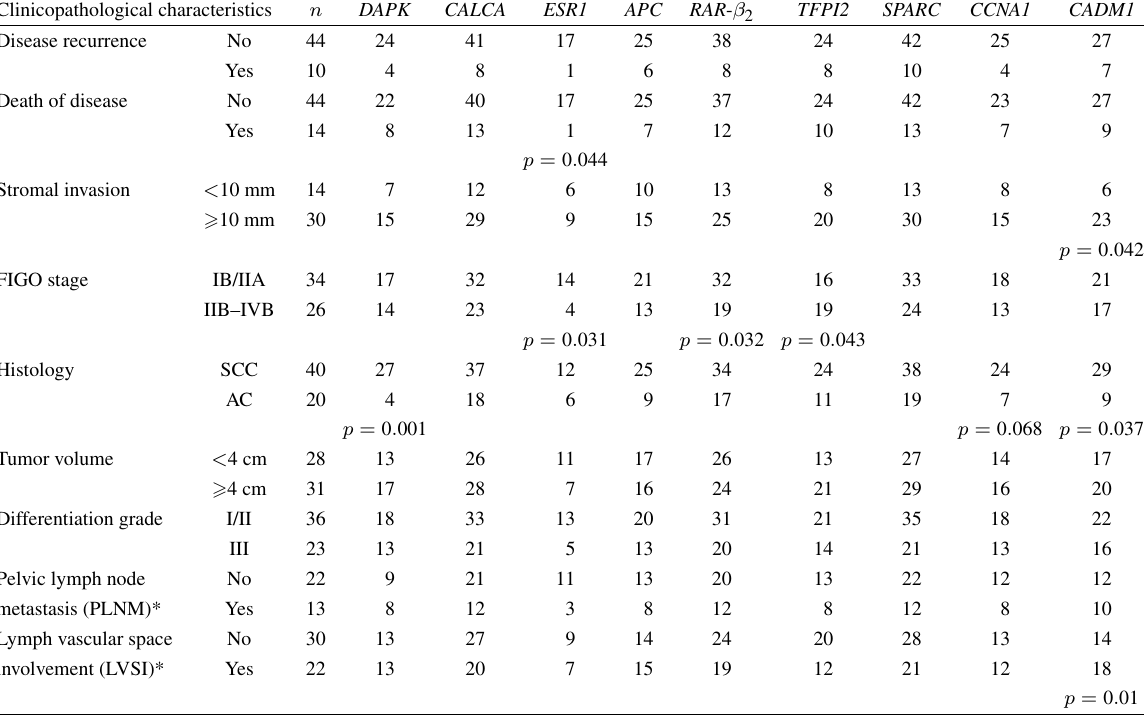
The number of positive methylated gene promoters in relation with the clinicopathological characteristics of 60 cervical cancer cases Clinicopathological characteristics Disease recurrence Death of